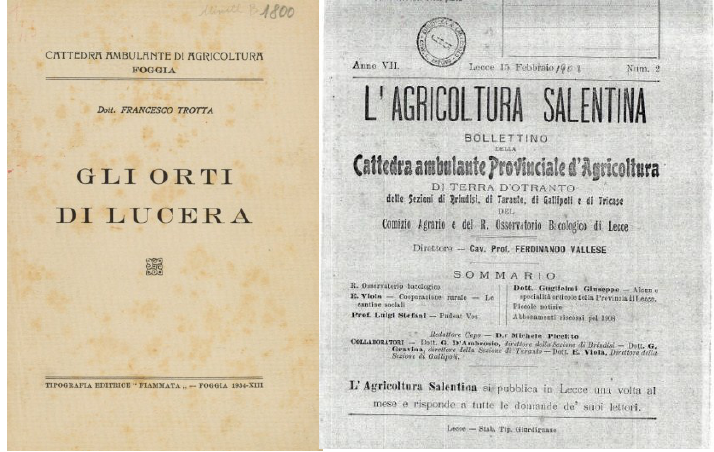
Figure 1. Examples of ancient documents recovered under the bibliographic research activity.